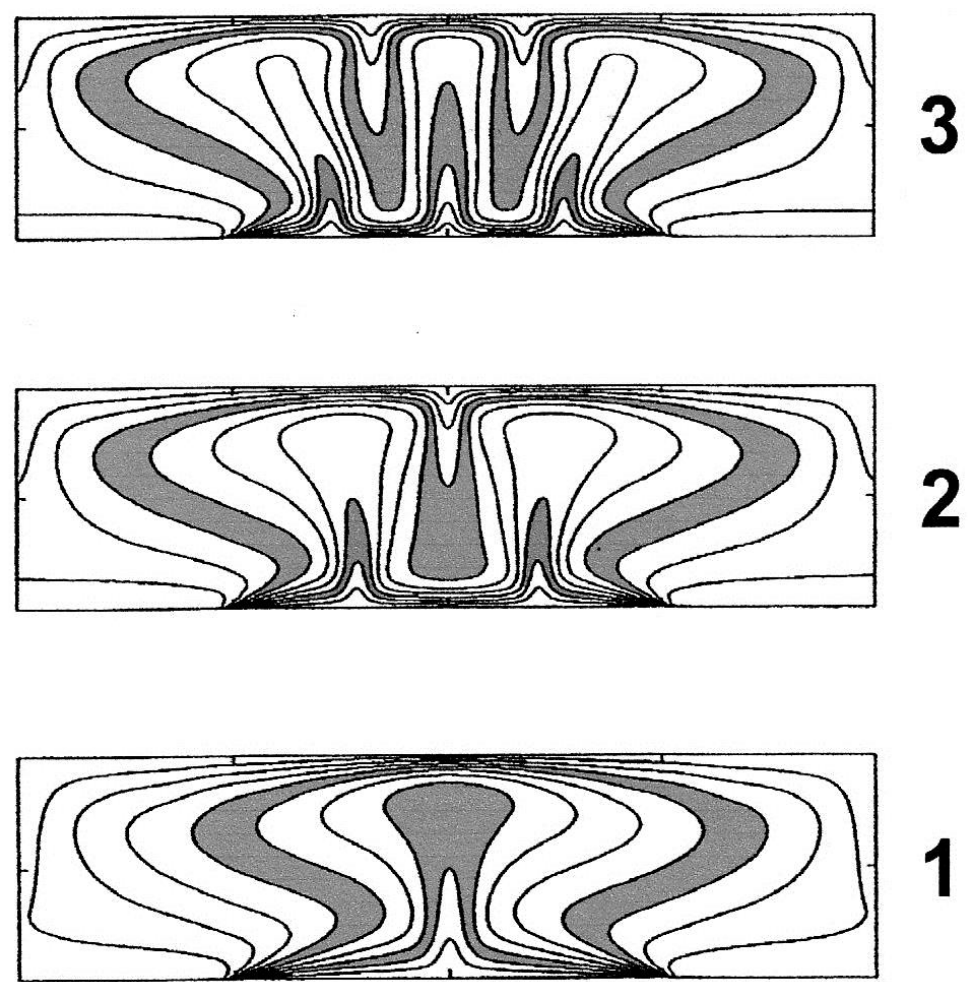
Figure 5. The temperature distribution for the 3 steady-state solutions S1 , S2 and S3 at Ra = 400 obtained by using different initial conditions. (The salinity results shown upside down as in the thermal version.) Bifurcations and possible steady state modes: 0 < Ra < 76, S1 only; 76 < Ra < 172, S1 and S2 ; 172 < Ra , S1 , S2 and S3 (only the S1 mode was found in JFM 1967 [2]) [For details see: Frolkoviˇc and De Schepper (2001) [3], Johannsen (2003) [6], van Reeuwijk et al. (2009) [7]]. [Modified from Figure 3 of van Reeuwijk et al. (2009) paper [7]. Reproduced with permission from Van Reeuwijk, M., et al., Insights from a pseudospectral approach to the Elder problem; published by American Geophysical Union, 2009.]